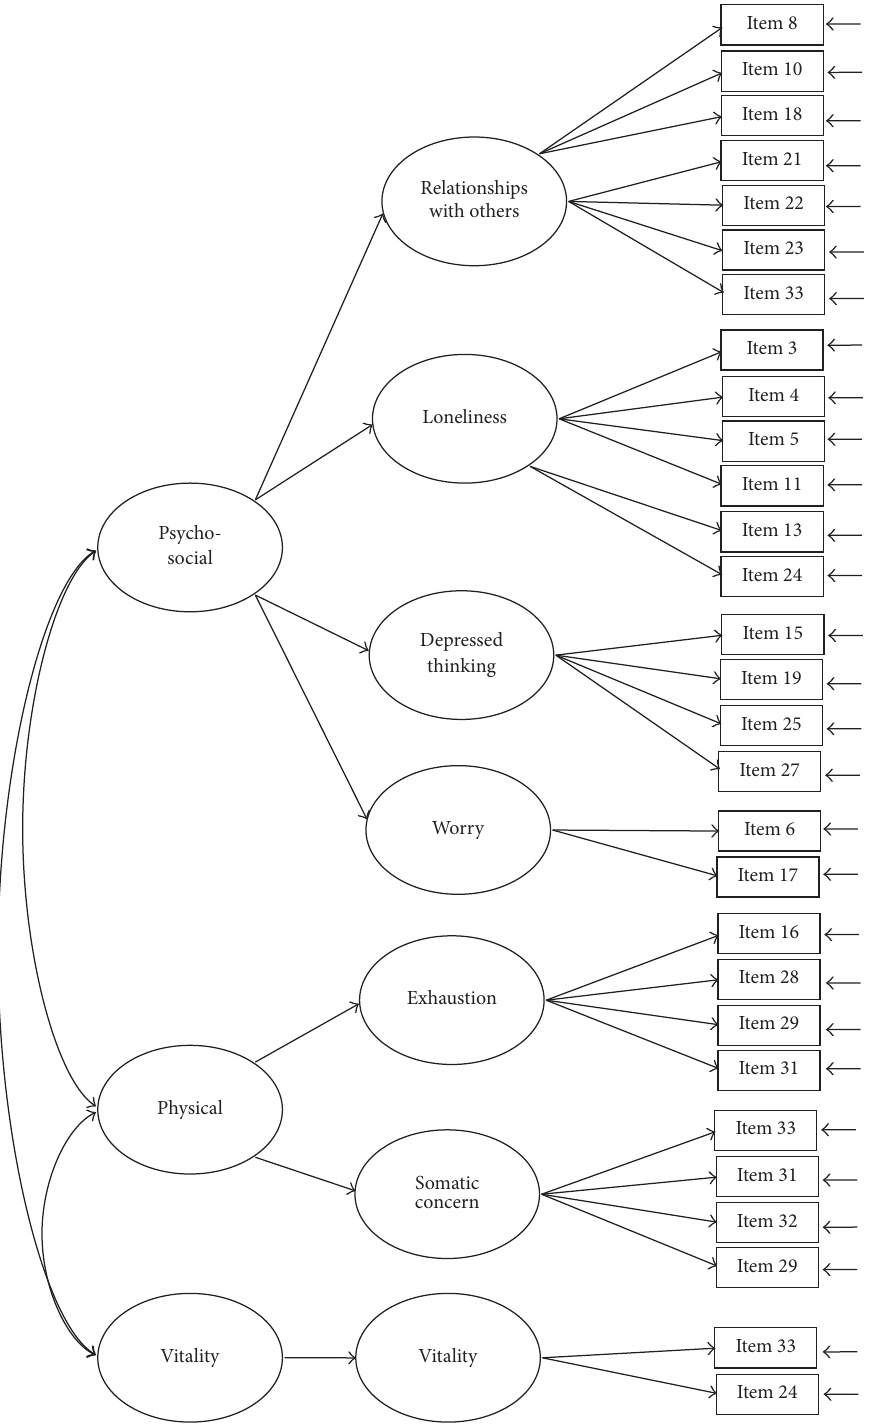
Figure 5: Model 5: the second-order model with 29 items. Item descriptions are in Table 3.